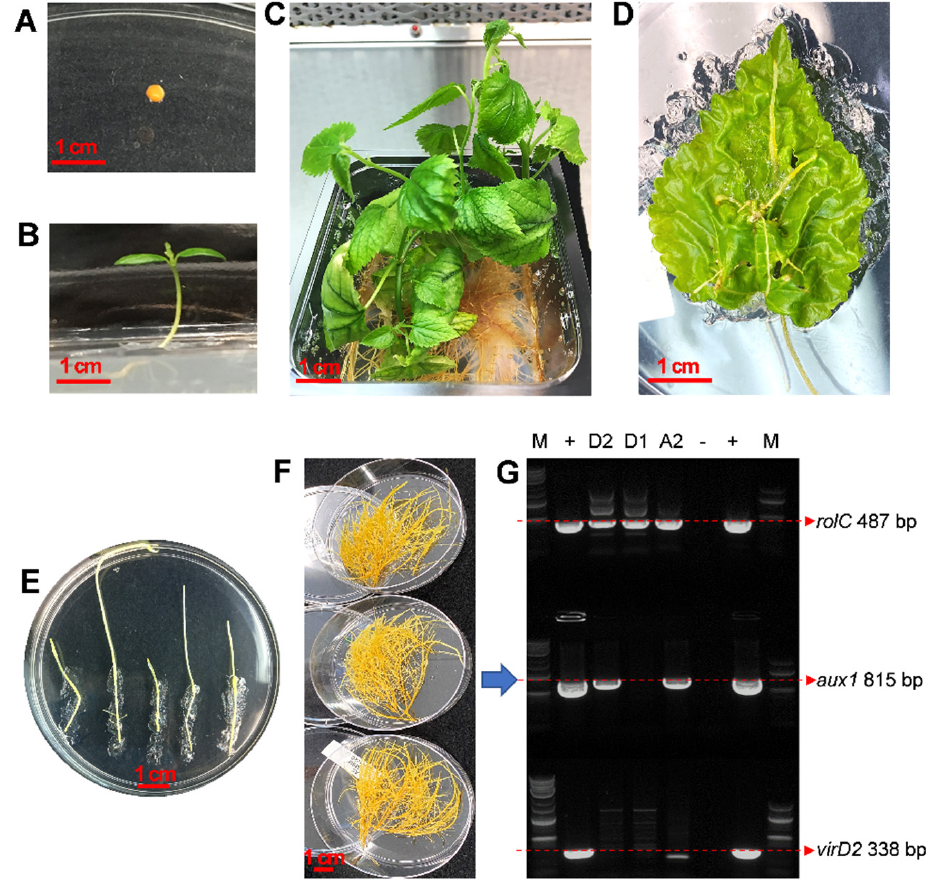
Figure 2. Establishment of hairy root cultures of white mulberry ( M. alba ) hairy root cultures. ( A ) Seed of white mulberry. ( B ) Two-week-old seedling. ( C ) Eight-week-old seedling. ( D ) Hairy root development from leaf infected with Agrobacterium rhizogenes . ( E ) Growth of hairy roots on semi-solid medium and selection based on growth. ( F ) Three selected lines after growth in liquid medium for 25 days. ( G ) PCR analysis of selected hairy root lines. Genomic DNA was isolated from hairy root lines U-A2, U-D1 and U-D2. Analyses were performed with primers targeting the rolC, aux1 and virD2 genes. Plasmid pRi15834 DNA was used as a positive control. ddH2O was used as a negative control. The bar in each panel corresponds to 1 cm.